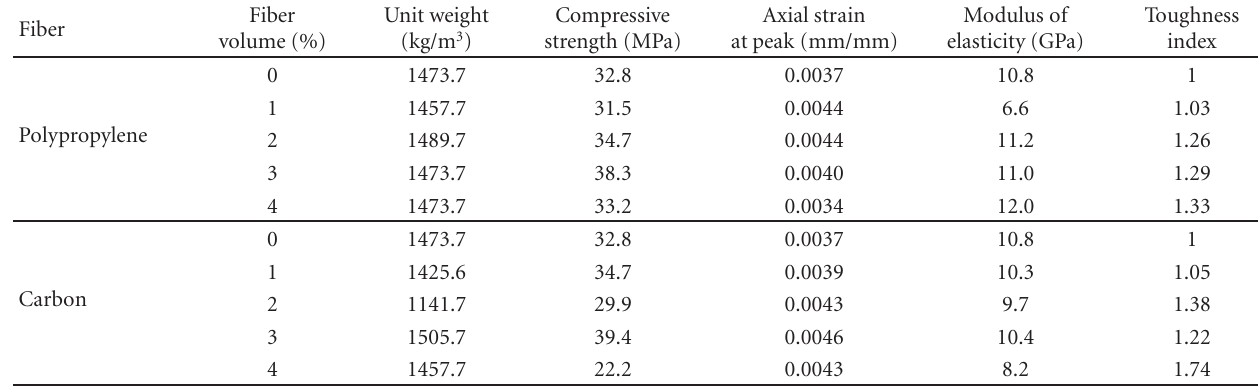
Table 5: Properties of fiber lightweight concrete (no surfactant).